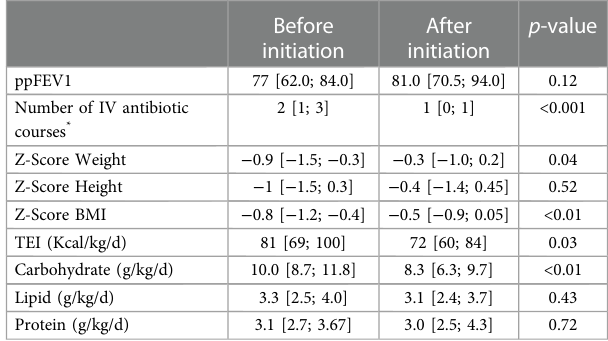
TABLE 5 Changes in clinical data and macronutrient intakes with lumacaftor/ivacaftor in patients with BMI<0 at